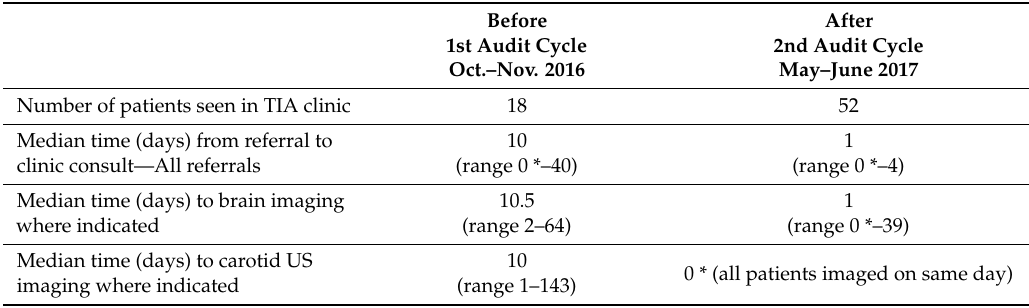
Table 2. Audit cycle results before and after implementation of the redesigned